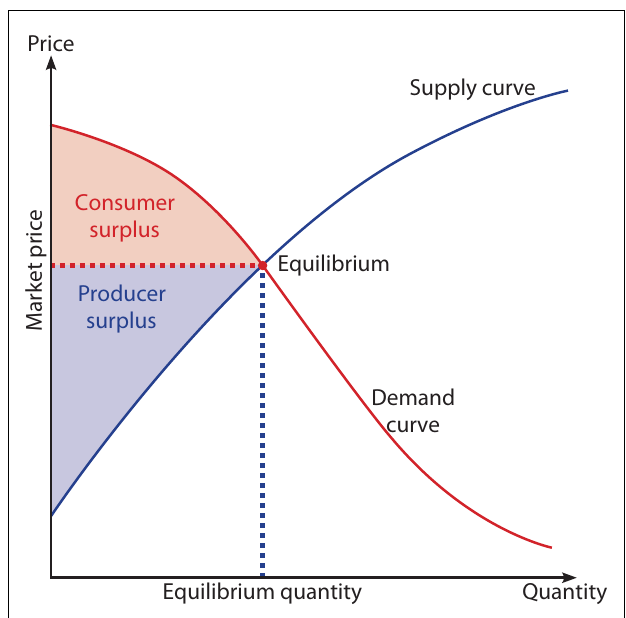
FIGURE 1 | Consumer and producer surplus in a supply-demand